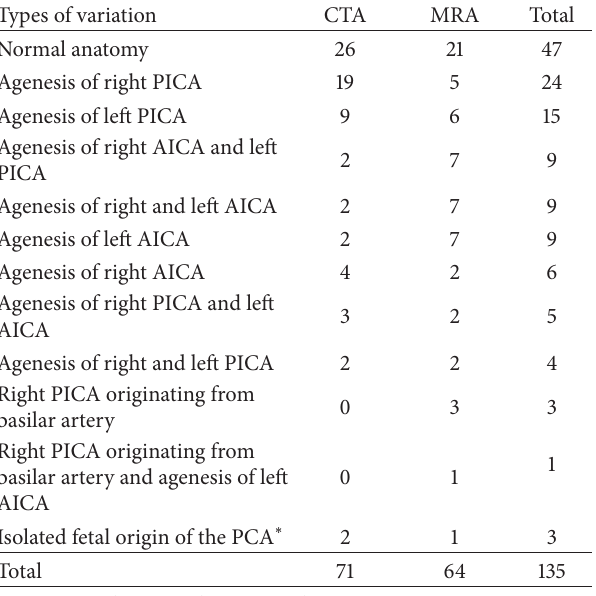
Figure 5: Oblique coronal view MIP TOF MR angiography image shows right PICA originating from the basilar artery in a 10-year- old girl. Thick long arrows = right and left PICAs, thin long arrows = right and left AICAs, thick short arrows = right and left SCAs, thin short arrows = right and left PCAs, and R = right. Table 2: Variations of the vertebrobasilar